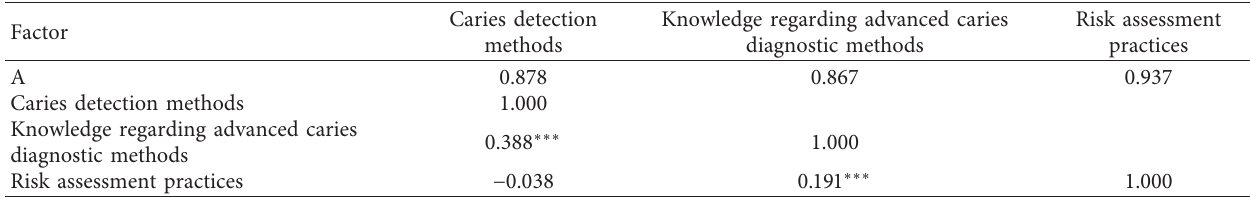
Table 6: Correlation matrix demonstrating caries detection methods, knowledge of advanced diagnostic methods, and caries risk as- sessment practices.